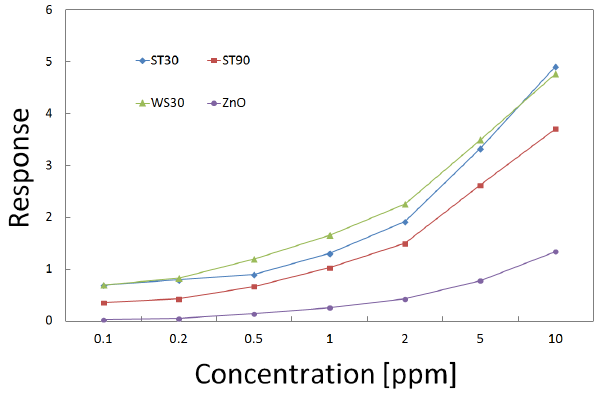
Figure 3. Responses vs. ammonia from 0.01 to 1ppm dispersed in a dry